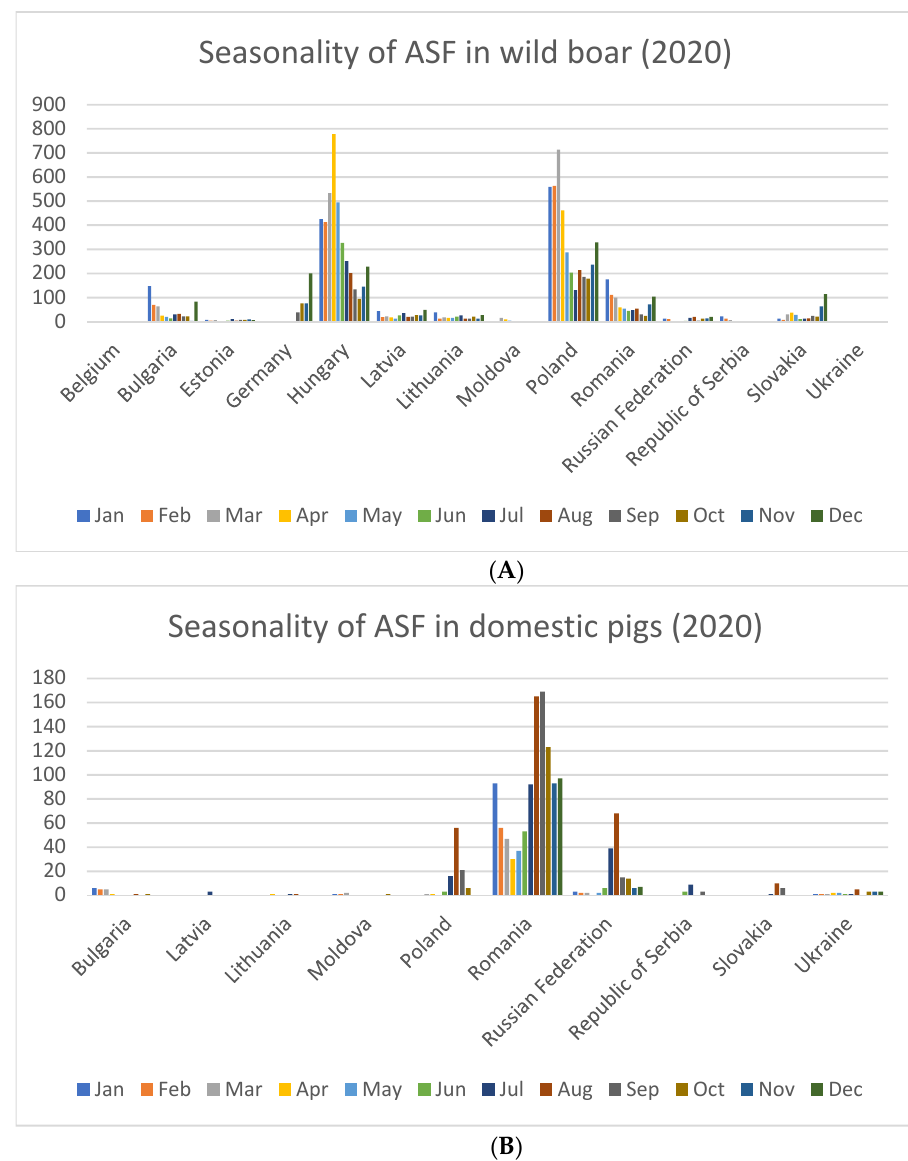
Figure 3. The occurrence and seasonality (monthly) of ASF outbreaks in wild boar ( A ) and ASF outbreaks ( B ) in domestic pigs in 2020. Source: General Veterinary Inspectorate: https://bip.wetgiw. gov.pl/asf/mapa/ (accessed on 30 July